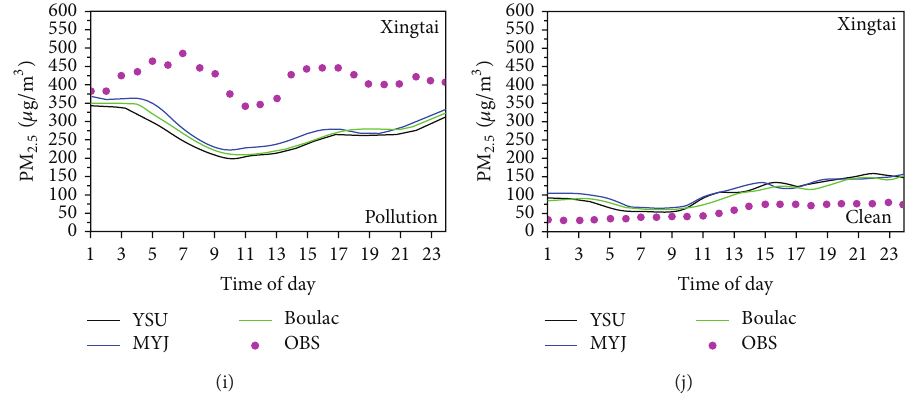
Figure 9: Diurnal variations of PM 2.5 in polluted ((a), (c), (e), (g), and (i)) and clean process ((b), (d), (f), (h), and (j)) at 5 sites of different